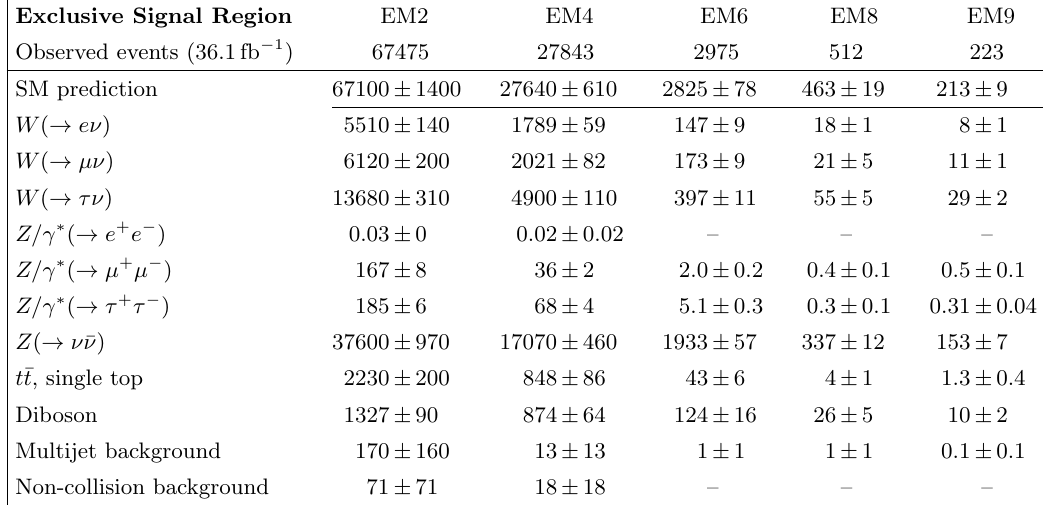
Table 4 . Data and SM background predictions in the signal region for several exclusive E miss selections, as determined using a binned likelihood (cid:12)t in the control regions. For the SM prediction, both the statistical and systematic uncertainties are included. In each signal region, the individual uncertainties for the di(cid:11)erent background processes can be correlated, and do not necessarily add in quadrature to the total background uncertainty. The dash \{" denotes negligible background contributions.